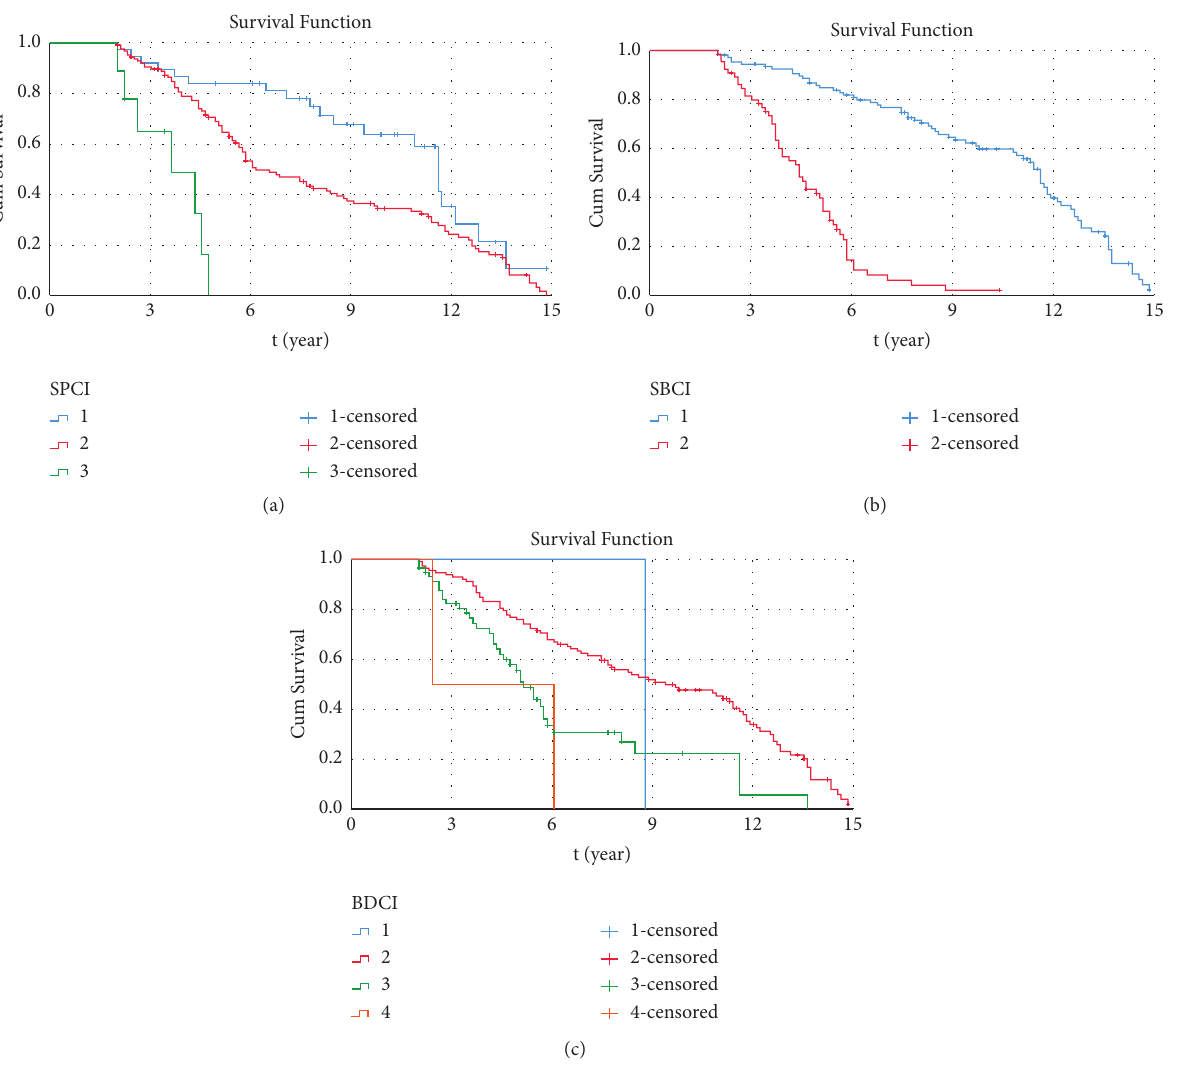
Figure 2: Survival curves for individual bridge structures. (a) Survival curves at each level of the superstructure score, (b) survival curves at each level of the substructure score, and (c) survival curves at each level of the bridge deck system. Table 2: Mean and median survival analysis times for